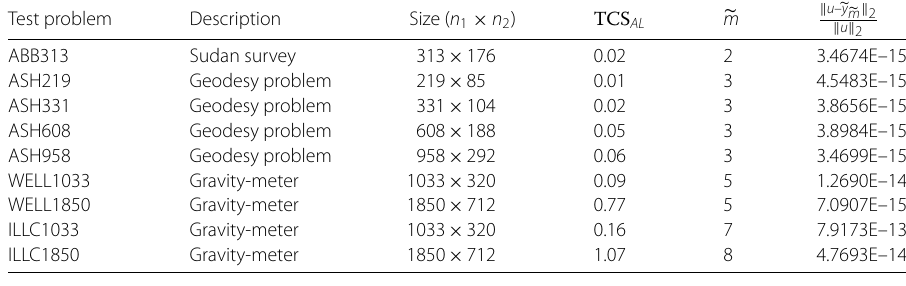
Table 2 TCS AL , iteration numbers, and relative L 2 norm of the errors obtained by Algorithm A for the test problems of Example 2 Test problem